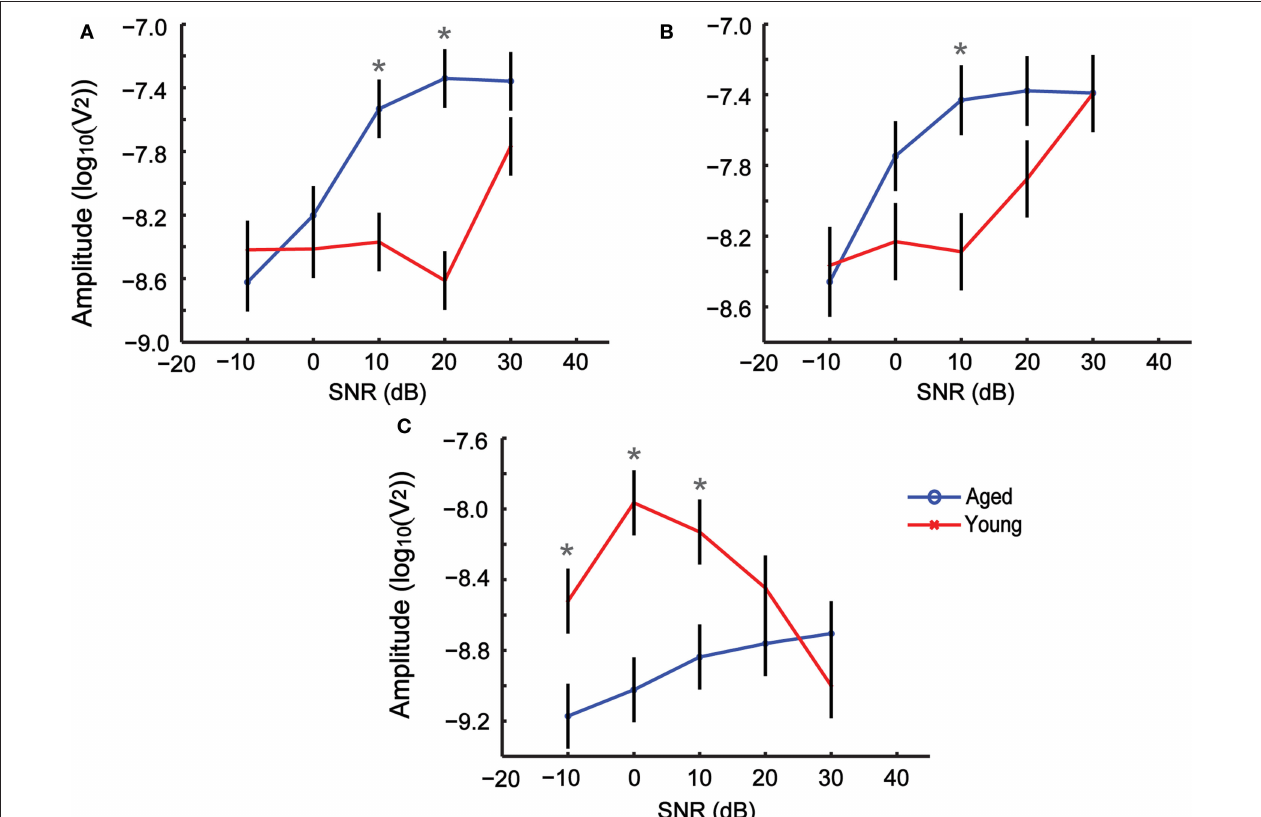
256, 512, and 1024 Hz respectively. The x axis indicates SNR, and the y axis indicates the LSM ± SE of the FFT amplitudes. Asterisks indicate statistically significant difference in LSMs ( P < 0.05,